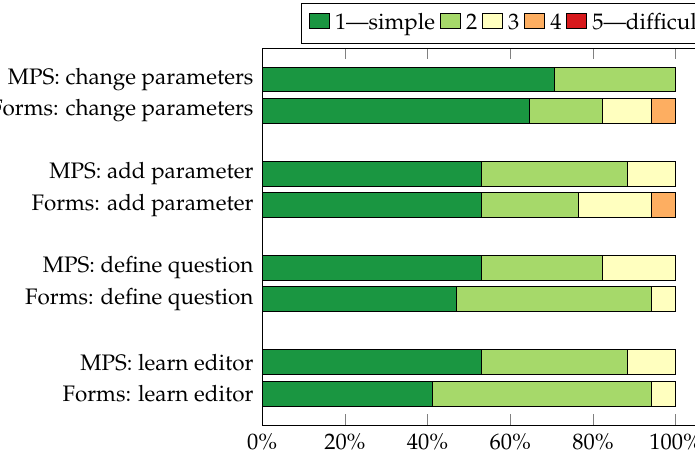
Figure 8. Survey results of the MPS vs.Google Forms